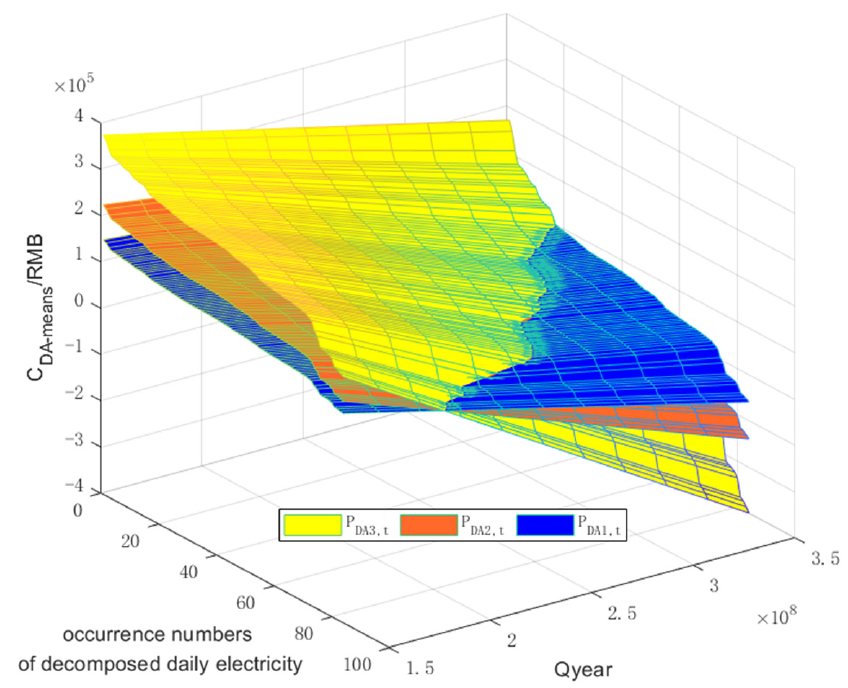
Figure 18. Electricity cost in the DA market based on 24-h average decomposition.